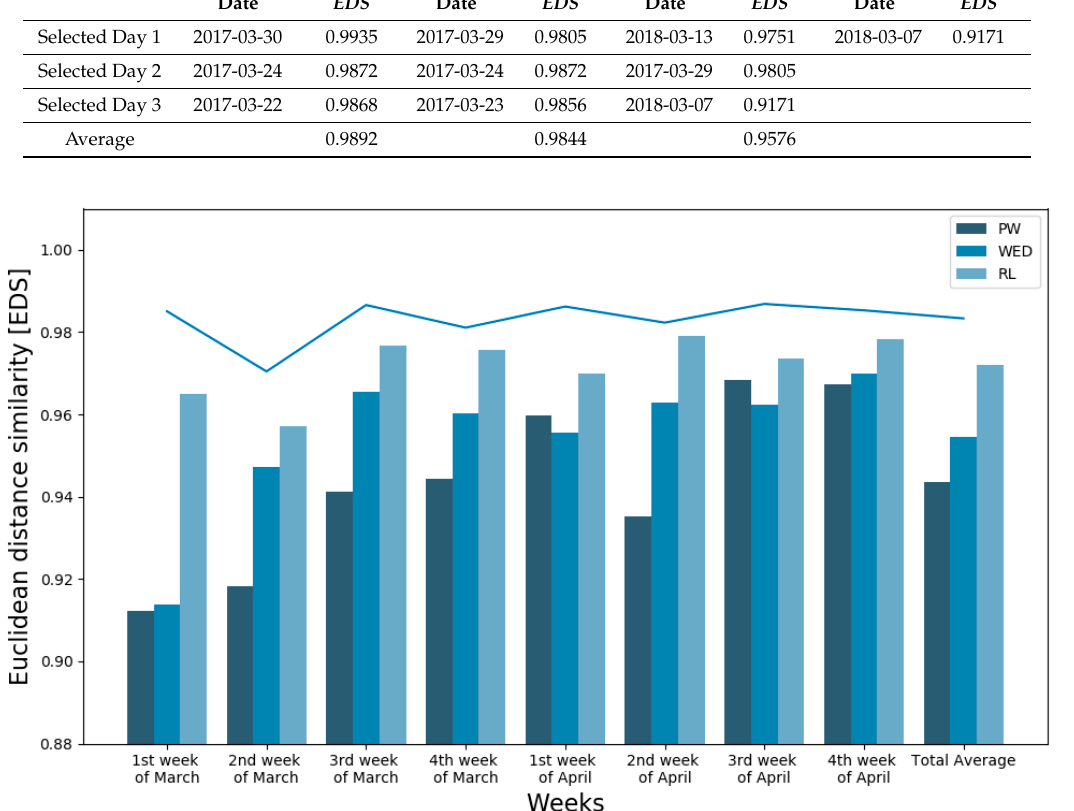
Figure 10. Similar day selection performance of the models in March and April 2018.